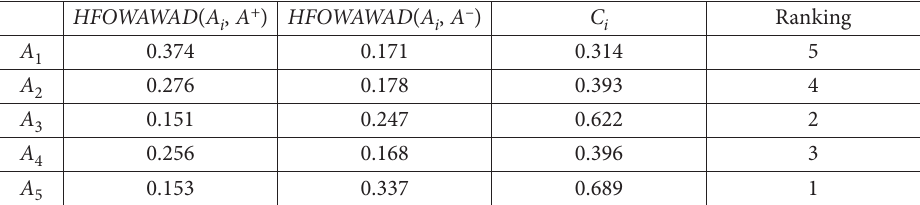
Table 3. Results obtained by the HFOWAWAD-TOPSIS